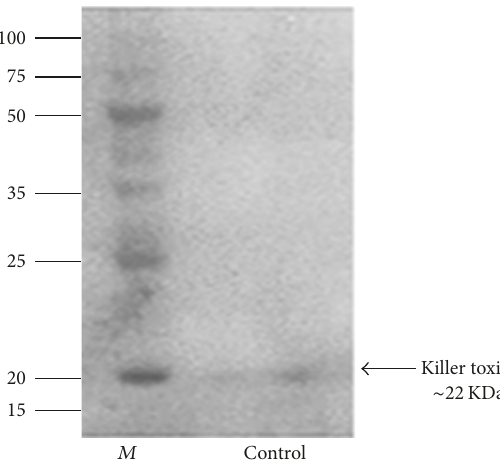
Figure 1: One-dimensional SDS-PAGE of partially purified concen- trated killer toxin. 12% SDS-PAGE was performed with the partially purified concentrated killer toxin produced by D. hansenii. The 22 kDaproteinisreferredtobyblackarrow.Lane M :thePageRuler (cid:3) Plus Unstained Rec. Protein Ladder (Promega), lane: referring to the purified protein under normal conditions. ∼ 15 𝜇 g of protein was loaded into the